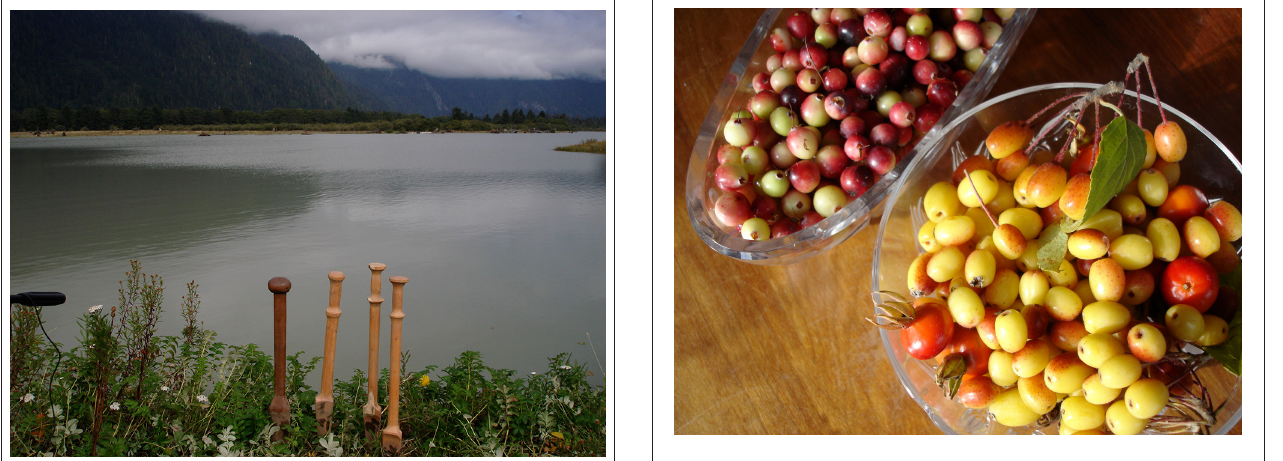
boxes, becoming softer and sweeter over time, to be consumed as needed throughout the winter. Root foods such as bulbs of camas, tigerlily, yellow glacier lily, chocolate lily, and northern and made into cakes or preserved loosely in bentwood